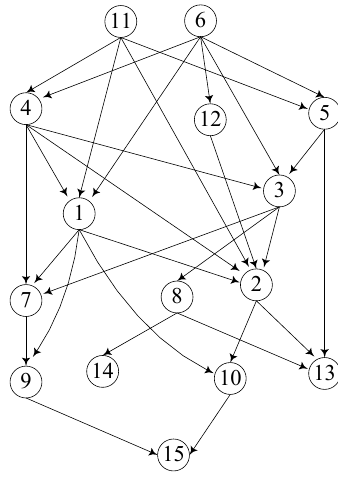
Figure 3. A sample DAG G .